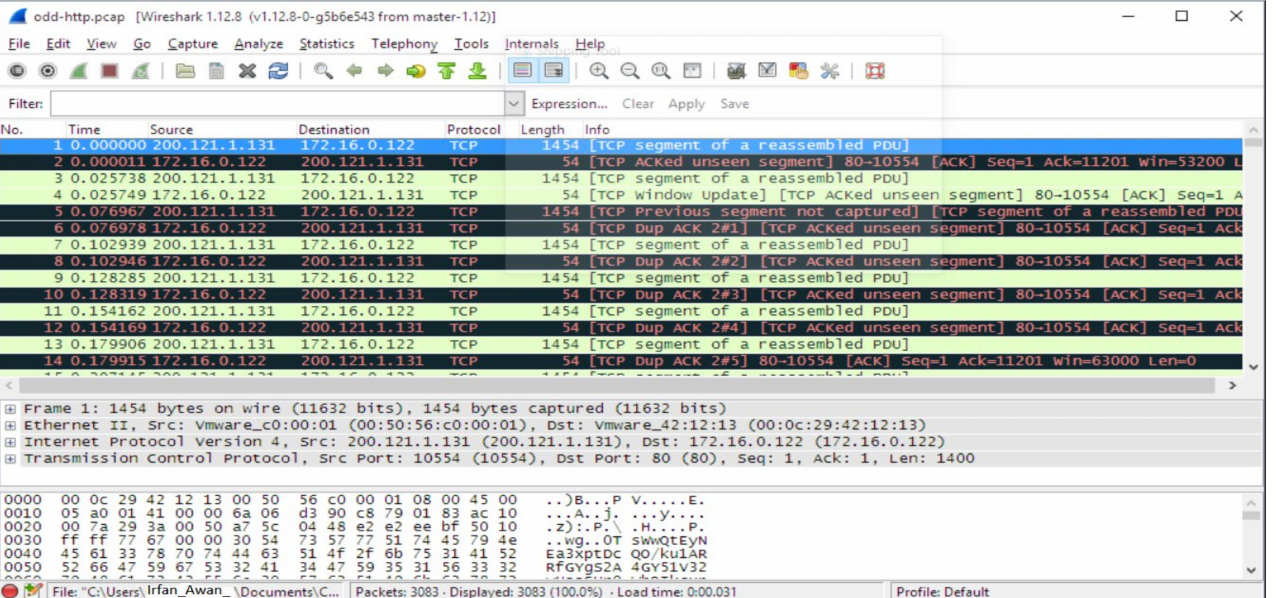
Figure 12. Packet analysis of Wireshark on Kali